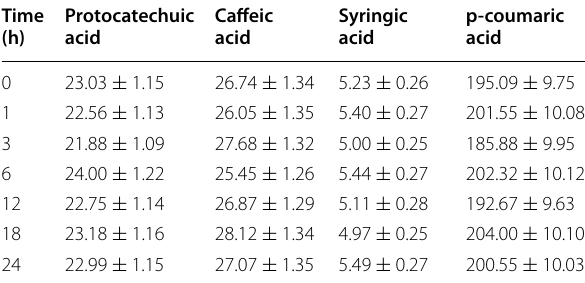
Significant difference was not observed between the phenolic acids (protocatechuic acid or caffeic acid or syringic acid or p-coumaric acid) at different time points (1, 3, 6, 12, 18, and 24 h) during fermentation and the respective phenolic acids at 0 h of fermentation